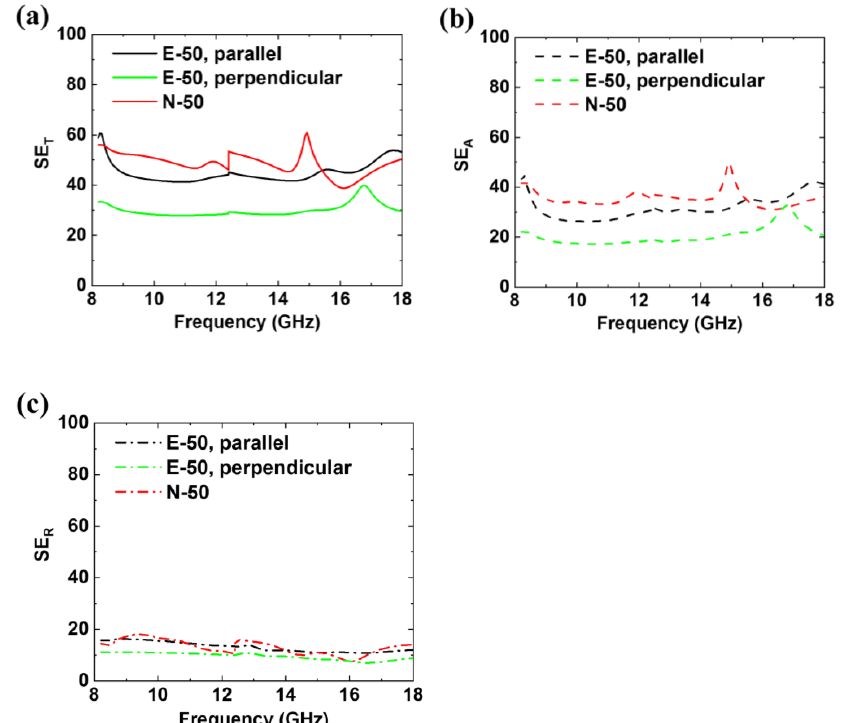
Figure 7. Measured EMI SE of E-50 in the direction parallel (black) and perpendicular (green) to the axial orientation of the NFs and N-50 (red) at the X- and K u -bands. The discontinuity at 12.4 GHz originates from the different waveguides for measurements at the X- and K u -bands. ( a ) Total EMI SE (SE T , continuous line) was calculated by the sum of ( b ) Absorption (SE A , dashed line) and ( c ) Reflection (SE R , dash-dotted line), which were obtained from measured S-parameters (S 11 and S 21 ) using a network analyzer. All the values in SE T are greater than 30 dB, which means that all the samples meet the commercial requirement for an EMI shield, and the portion of the SE A accounts for much more than that of SE R for the total EMI SE. In addition, the anisotropic characteristic of E-50 is also exhibited by its electrical conductivity.